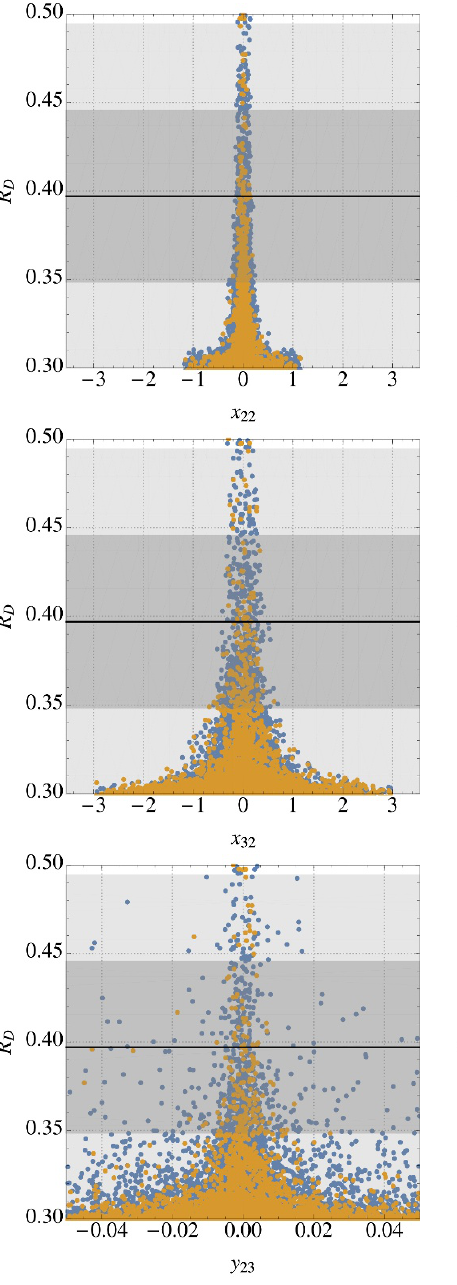
from the SM LL since these D K